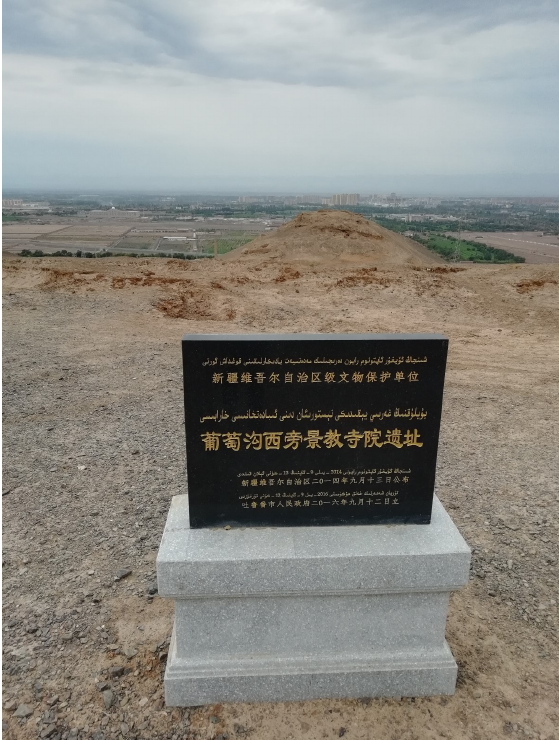
Figure 2 Sign in Chinese and Uighur declaring the site as culturally protected (photo by David